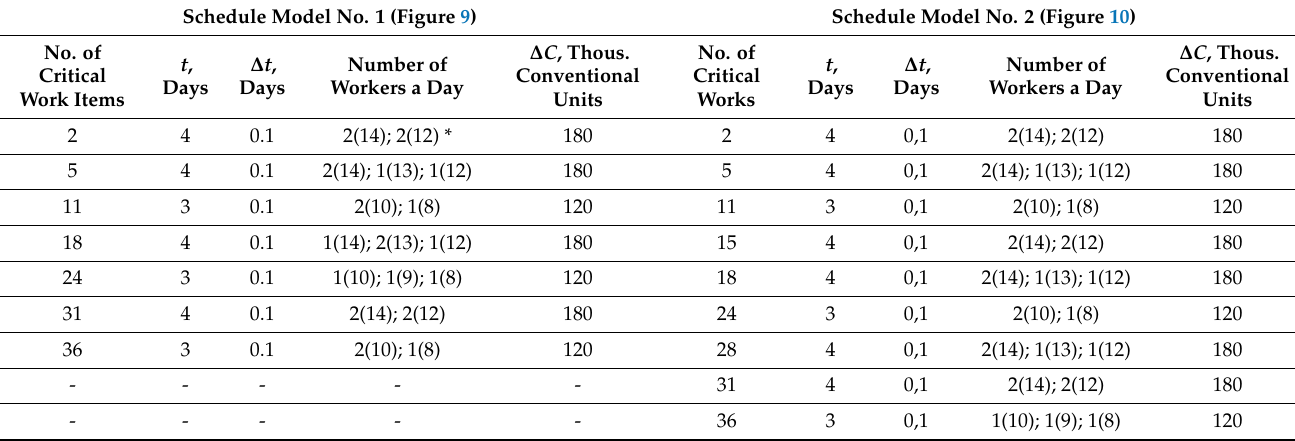
Table 2. Input data used in risk assessment for schedules.